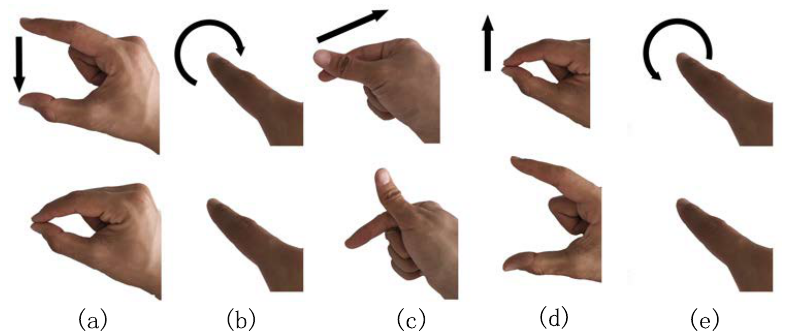
Figure 9. Illustrations of five finger gestures: ( a ) finger close, ( b ) finger clockwise circle, ( c ) finger slide, ( d ) finger open, ( e ) finger counterclockwise circle.